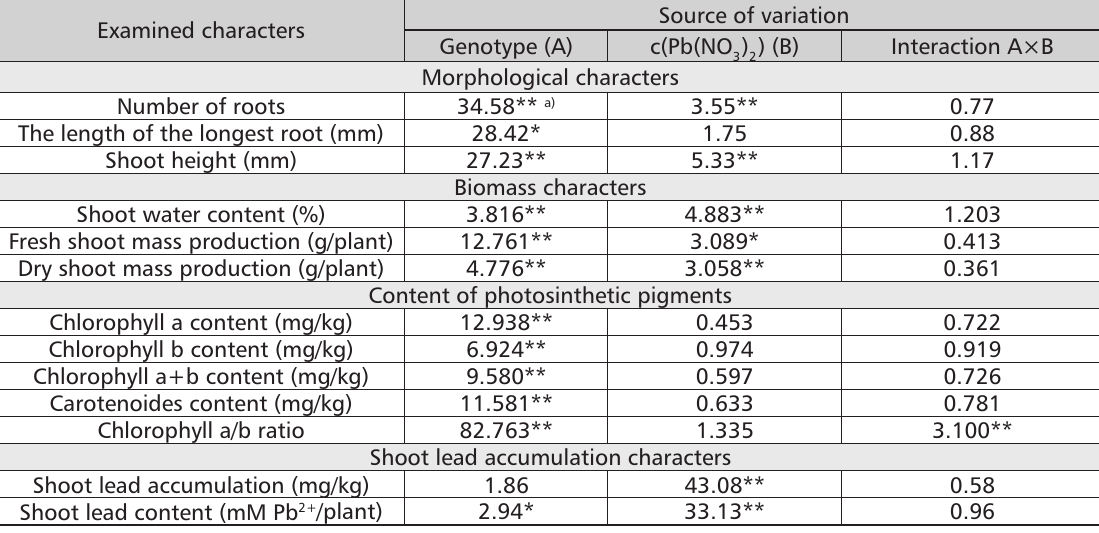
Results of F-test for examined characters in white poplar genotypes on examined